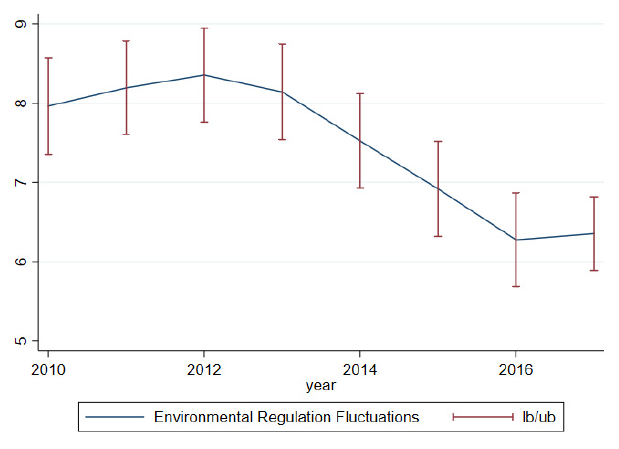
Figure 1. Environmental regulation fluctuations in China. Note: The sample is from 2010 to